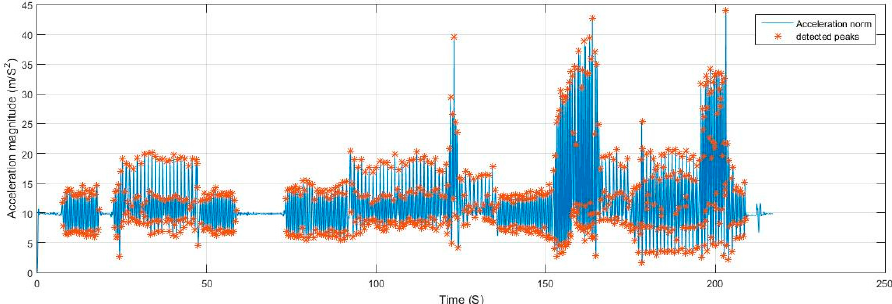
Figure 17. Filtered acceleration norm from Test 1 with detected peaks.